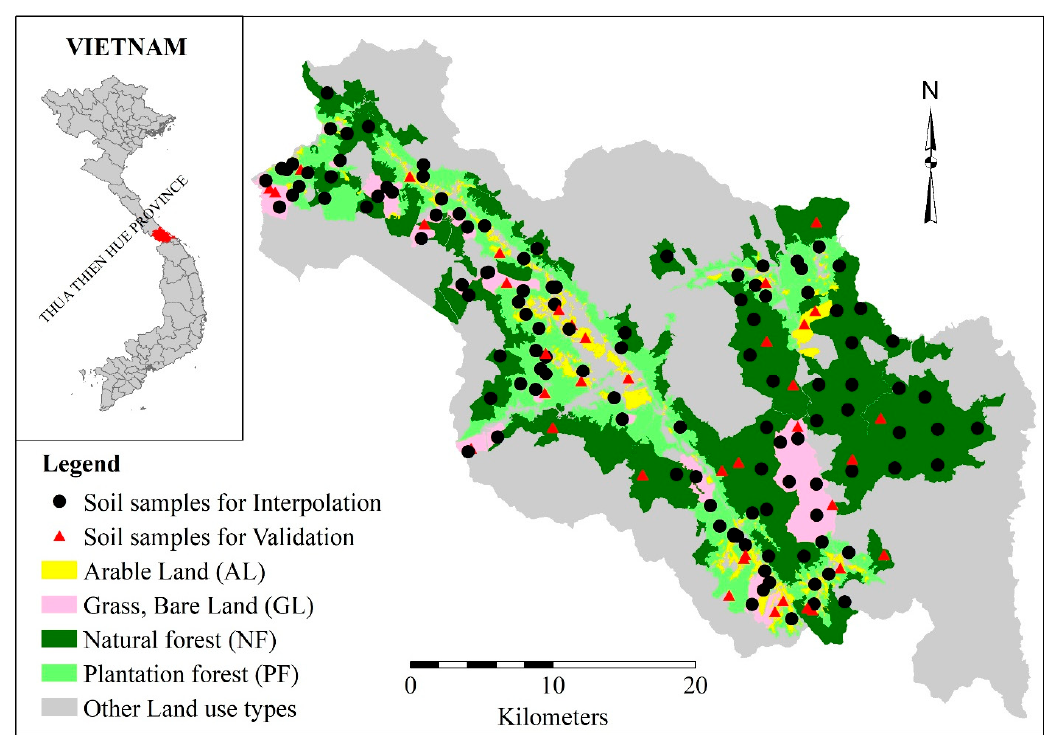
Figure 1. Land Use Map and Soil sampling positions.